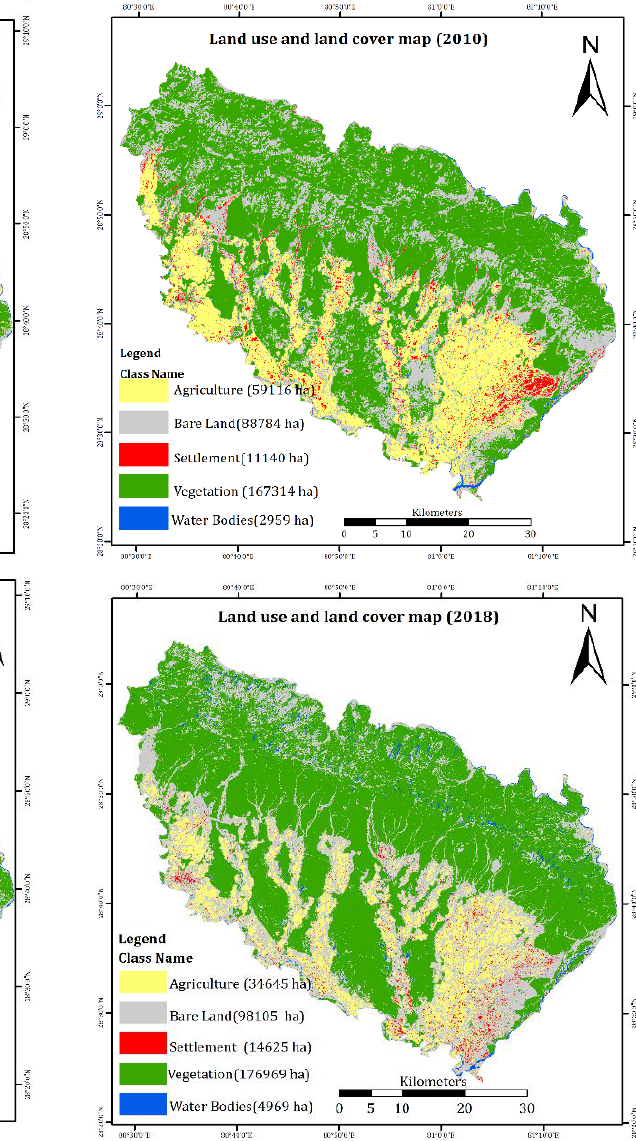
Figure 2: LULC map of Kailali District for years 1990, 2000.